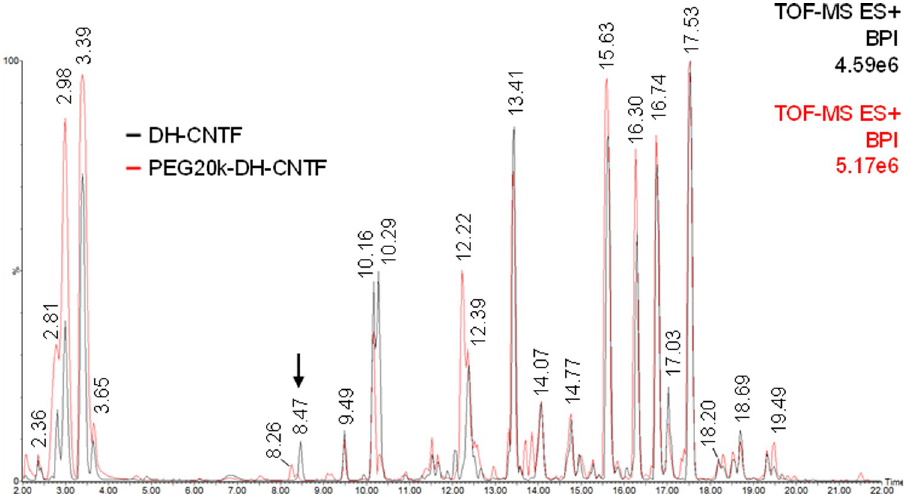
Fig 4. BPI chromatograms of LC-MS E analysis of DH-CNTF (black) and PEG20k-DH-CNTF (red) upon digestion with trypsin. The peak labelled with an arrow in the figure is the Cys17-containing peptide F3 [15–19].